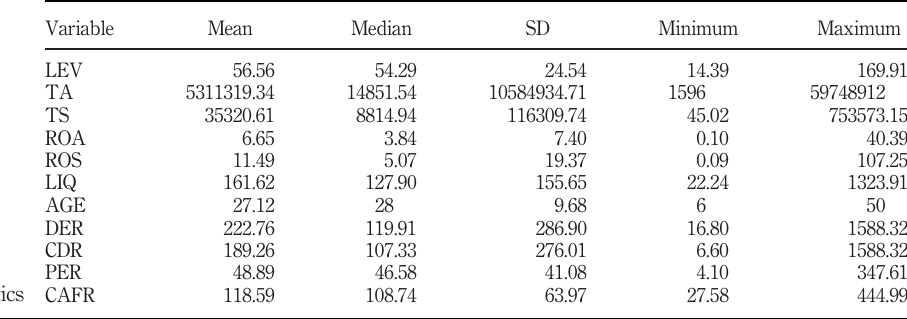
independent variables and their description as used in the